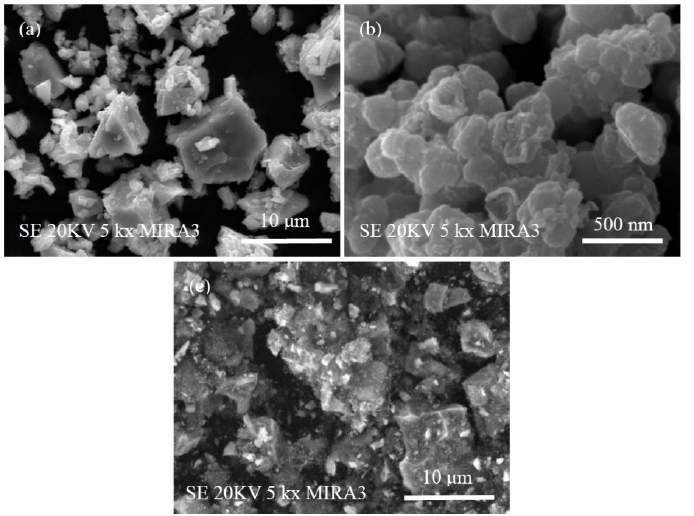
Figure 1. SEM images of powders: ( a ) Ti micro-particle powder, ( b ) B 4 C nano-particle powder, ( c ) Ti and B 4 C mixed powder. and B 4 C mixed